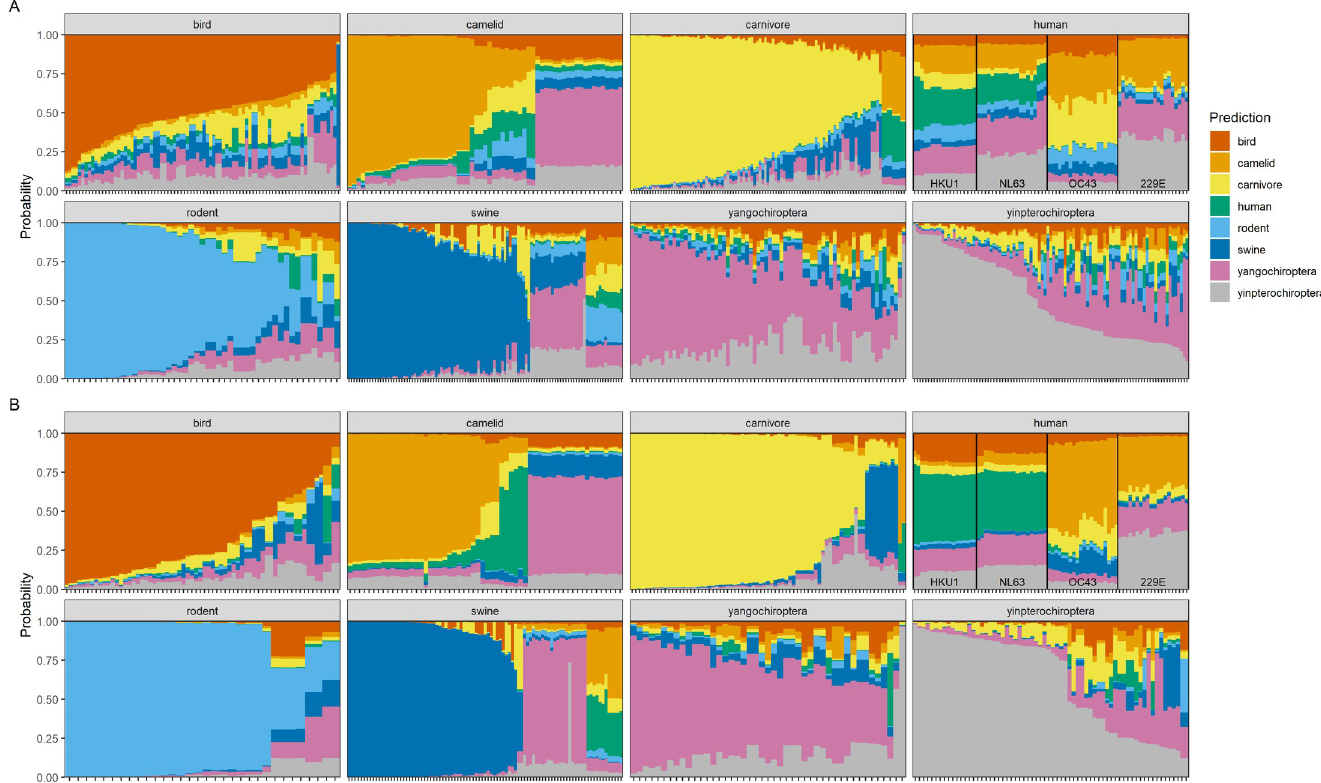
Fig 3. Random forest host predictions based on coronavirus genome composition. Stacked bar plots of predicted probabilities of each host category for coronavirus sequences. Predictions were obtained from ensemble random forest models trained on A) spike protein and B) whole genome composition features. Panels depict sequences from each metadata-derived host category and colour coding denotes model-predicted host category. Stacks represent individual coronavirus sequences, ordered from largest to smallest probability of the correct host, i.e., greater panel area matching the correct host category indicates better overall model performance. Non-zoonotic coronavirus sequences originating from humans (human coronaviruses HKU1, NL63, OC43, 229E) are labelled for clarity. Versions stratified by genera and species are provided as S4 and S5 Figs.